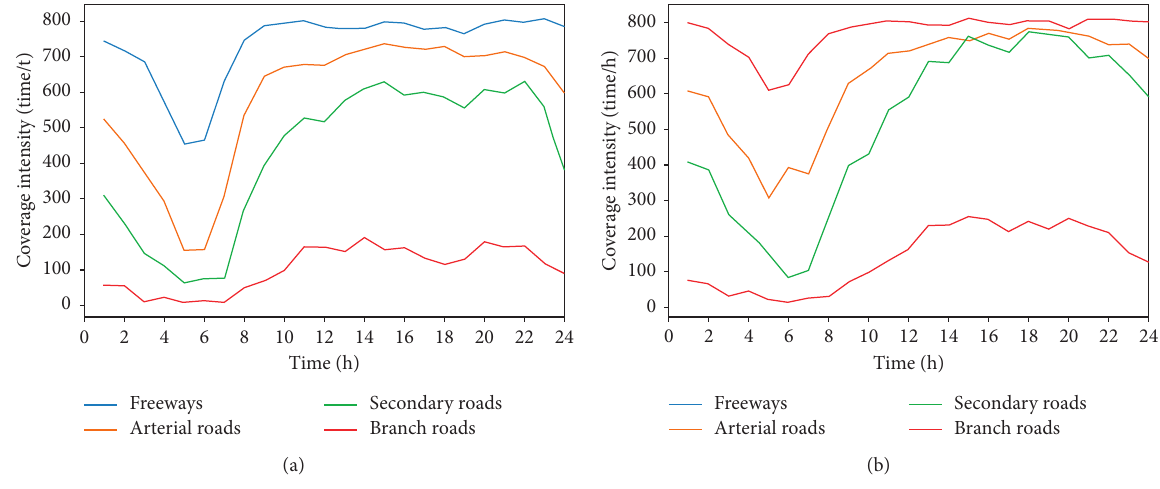
Figure 1: Changes in average coverage intensity within 24 h via grade roads: (a) weekday; (b) off day.